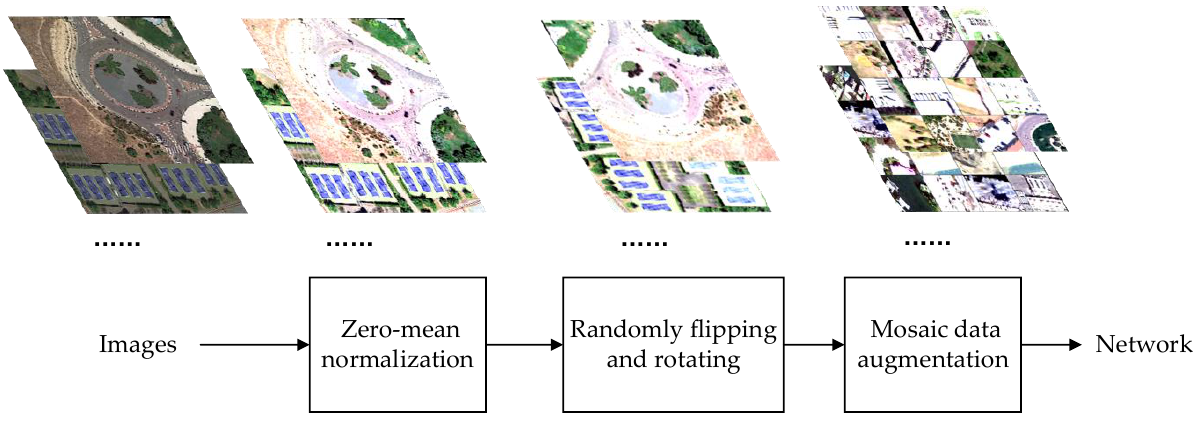
Figure 5. Data normalization and augmentation during training.